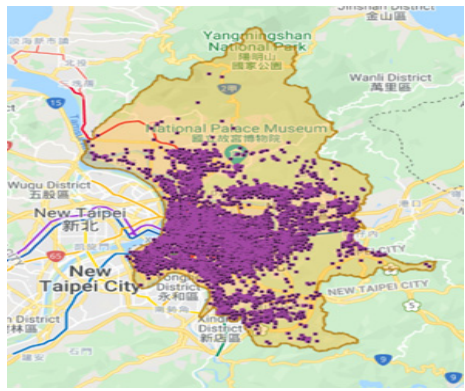
Figure 7. The distribution of the targeted points in Taipei City.